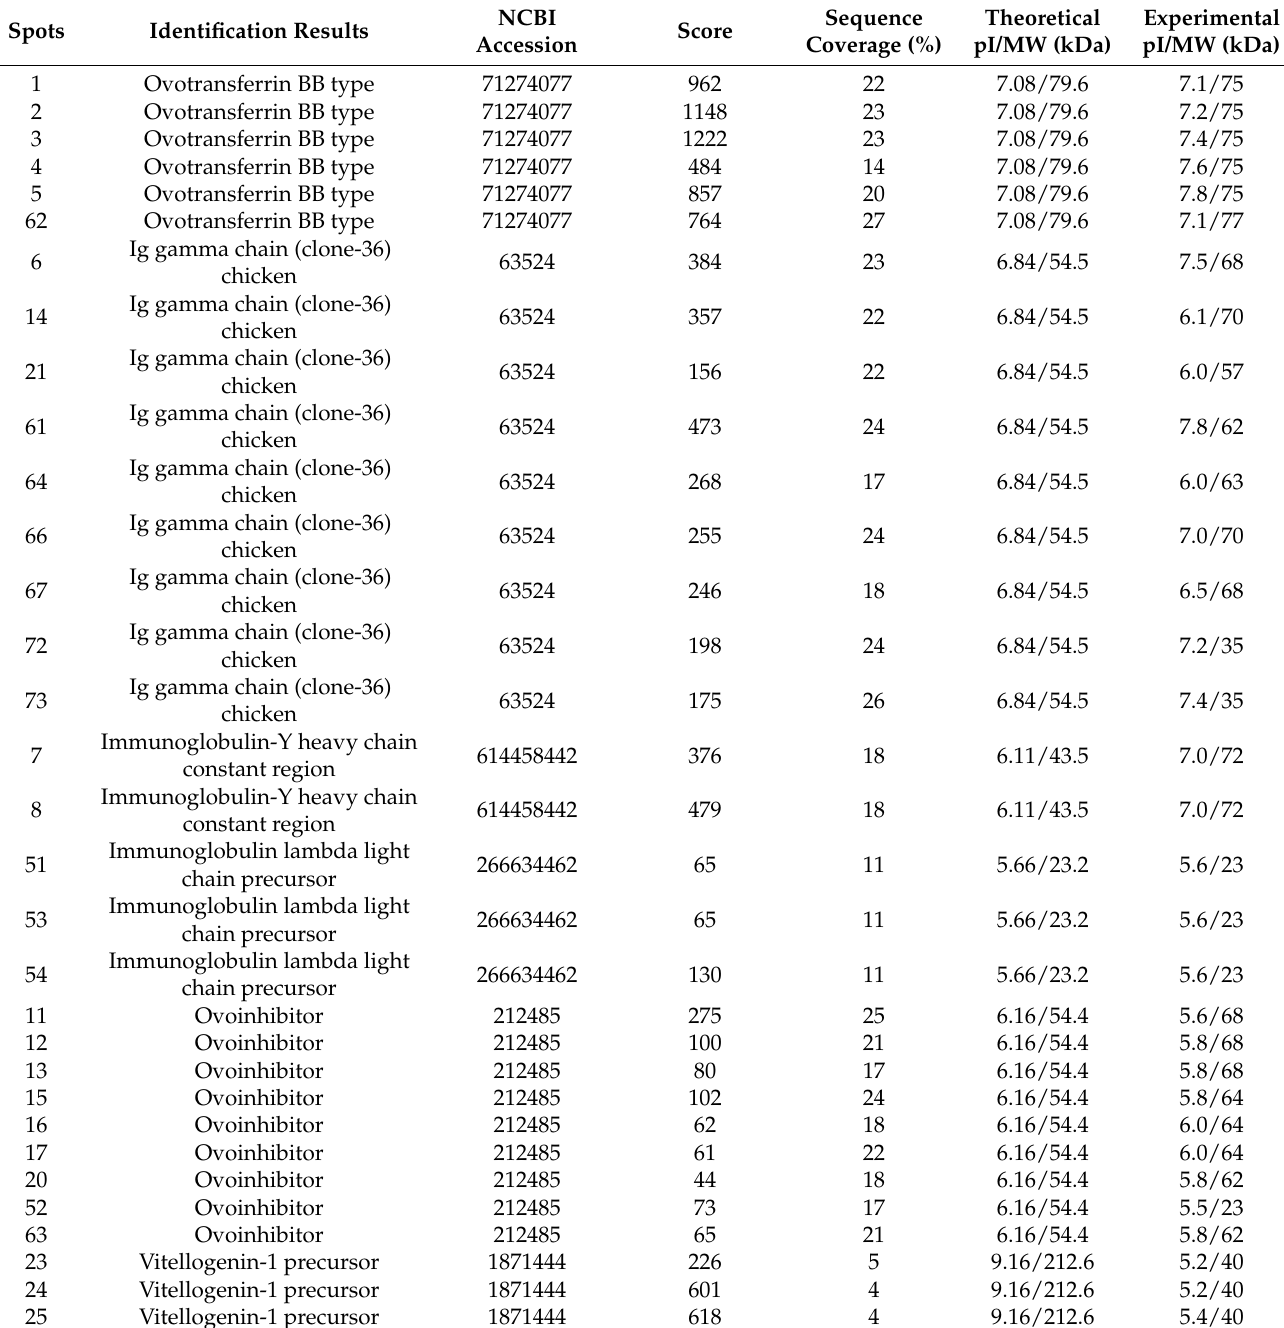
Table 1. The table enlisted all of the proteins detected in low and high cholesterol groups with their theoretical and experimental pI and MW values, accession numbers, score, and sequence